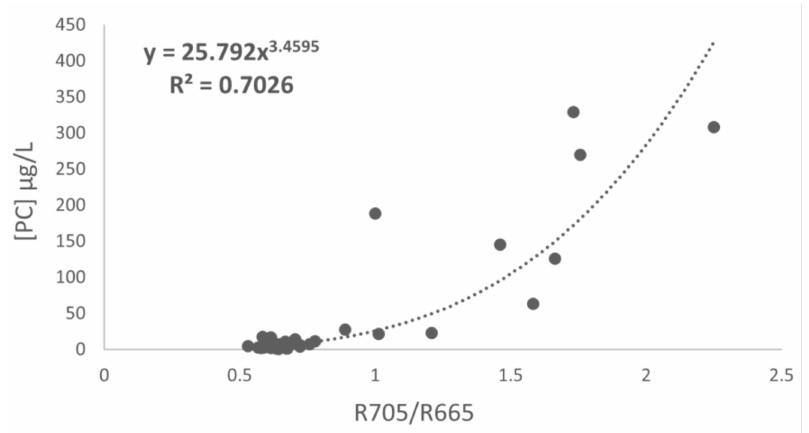
Figure 4. Correlation between the R705/R665 ratio and PC observed in the reservoir.